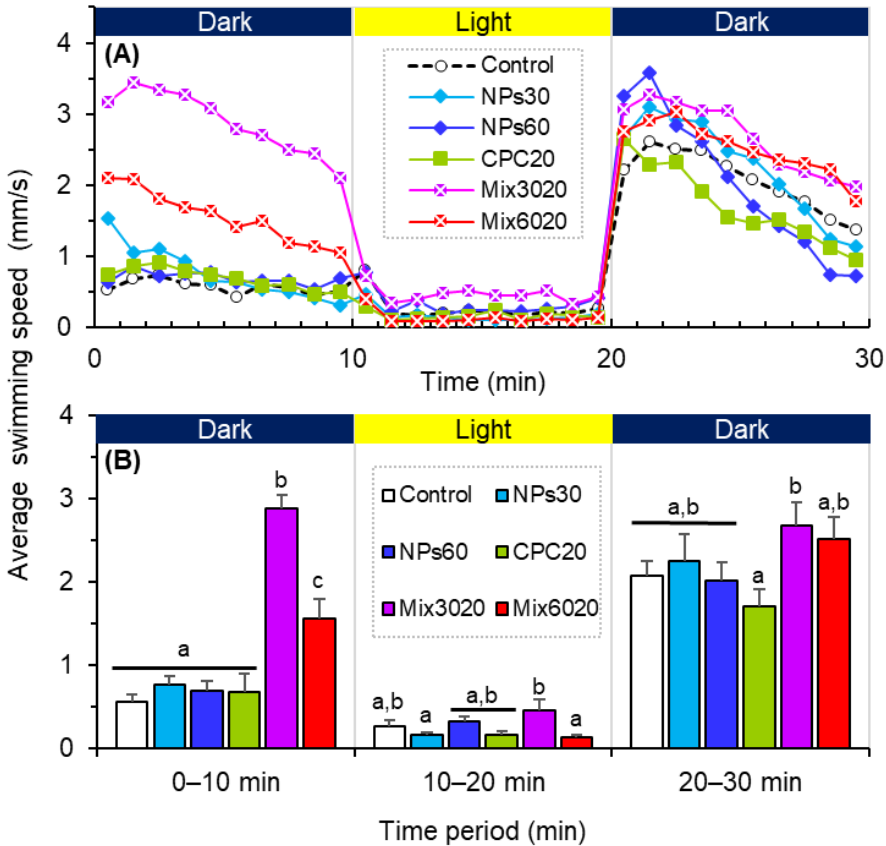
Figure 3. The average swimming velocity of larval zebrafish ( Danio rerio ) in the combined exposure groups of cetylpyridinium chloride (CPC; 0 and 20 μ g/L) and ZIF-8 nanoparticle (ZIF-NPs; 0, 30, and 60 mg/L). ( A ) Mean value within each 1-min interval. ( B ) Means ± SE ( n = 18) within each 10-min period, and values that do not share a common letter are significantly different at p < 0.05. Control: ZIF-NPs = 0 mg/L, CPC = 0 μ g/L; NPs30: ZIF-NPs = 30 mg/L, CPC = 0 μ g/L; NPs60: ZIF-NPs = 60 mg/L, CPC = 0 μ g/L; CPC20: ZIF-NPs = 0 mg/L, CPC = 20 μ g/L; Mix3020: ZIF-NPs = 30 mg/L, CPC = 20 μ g/L; Mix 6020: ZIF-NPs = 60 mg/L, CPC = 20 μ g/L.